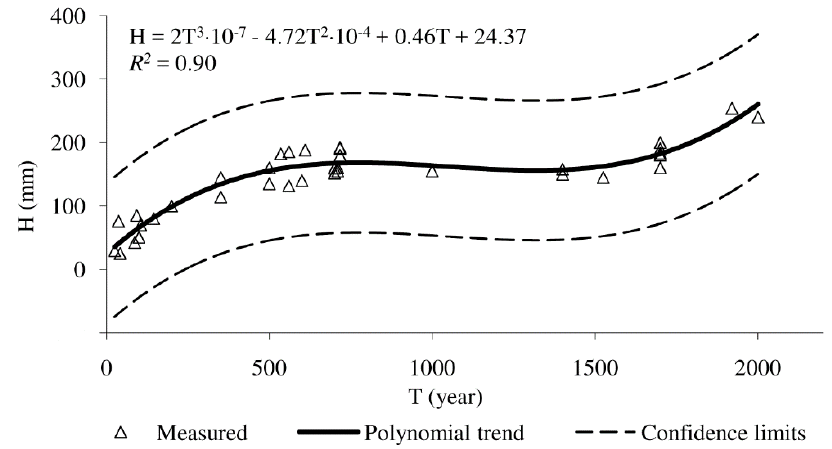
Figure 4. Chronofunctions of changes of the humus horizon (H, mm) of the calcaric Cambisols over time (T, years). Confidence limits (P = 0.95).